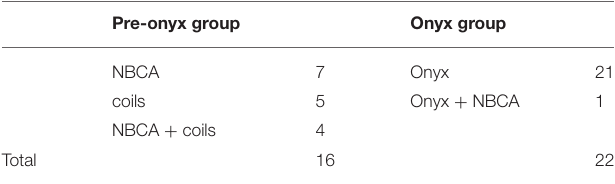
TABLE 3 | Embolization